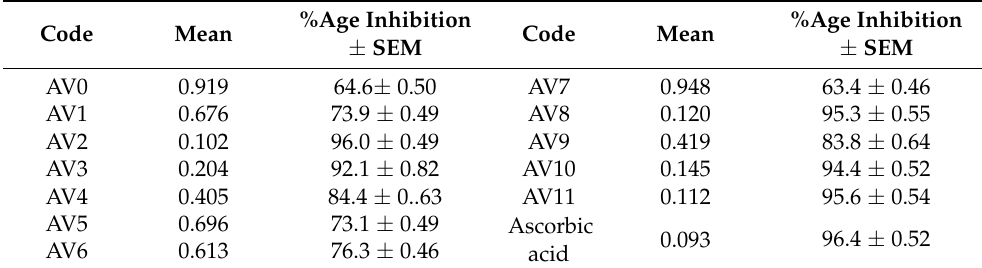
Table 2. Results of radical scavenging activity of synthesized derivatives of2-(N-((2 (cid:48) -(2H-tetrazole-5-